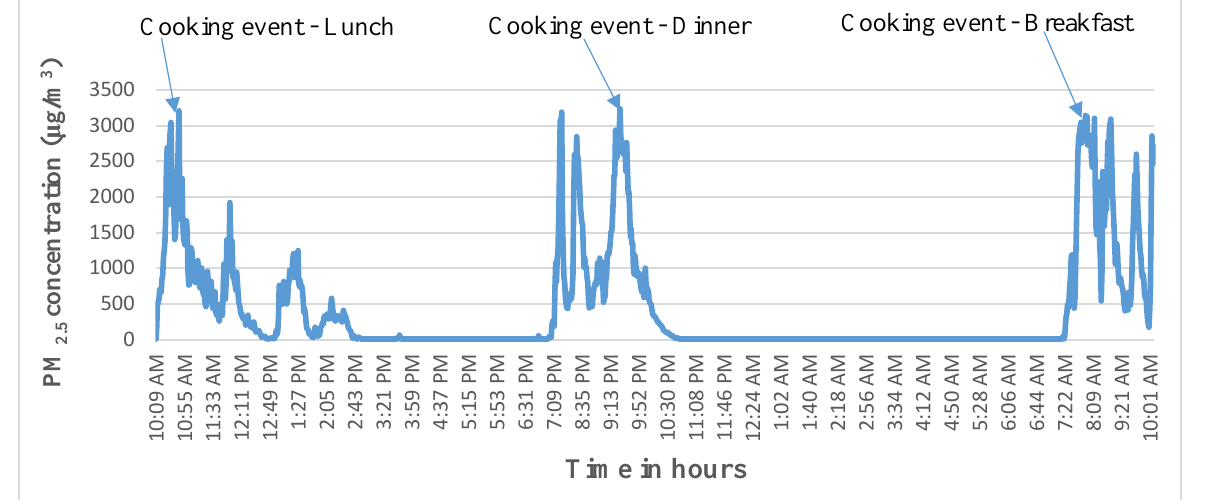
Table 2. Mean PM 2.5 concentration in relation to cooking and housing conditions.